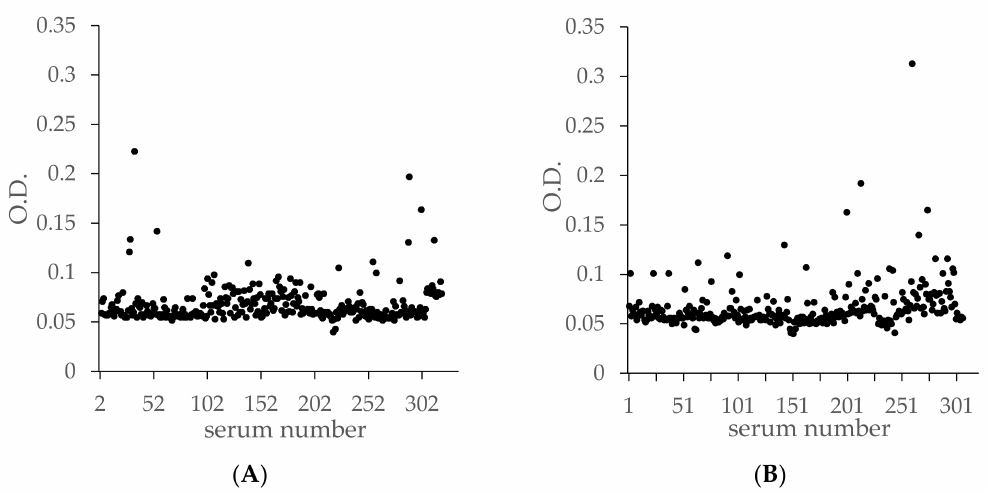
Figure 2. OD ELISA results from naïve ( A ) or BTV-1, 2, 8, 9 and 16 infected or vaccinated sera ( B